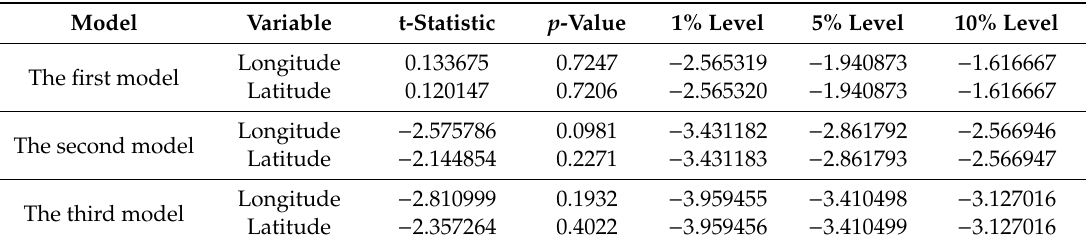
Table 2. The Augment Dickey-Fuller (ADF) test results of the longitudes and latitudes of trajectory points of the shadowed taxi